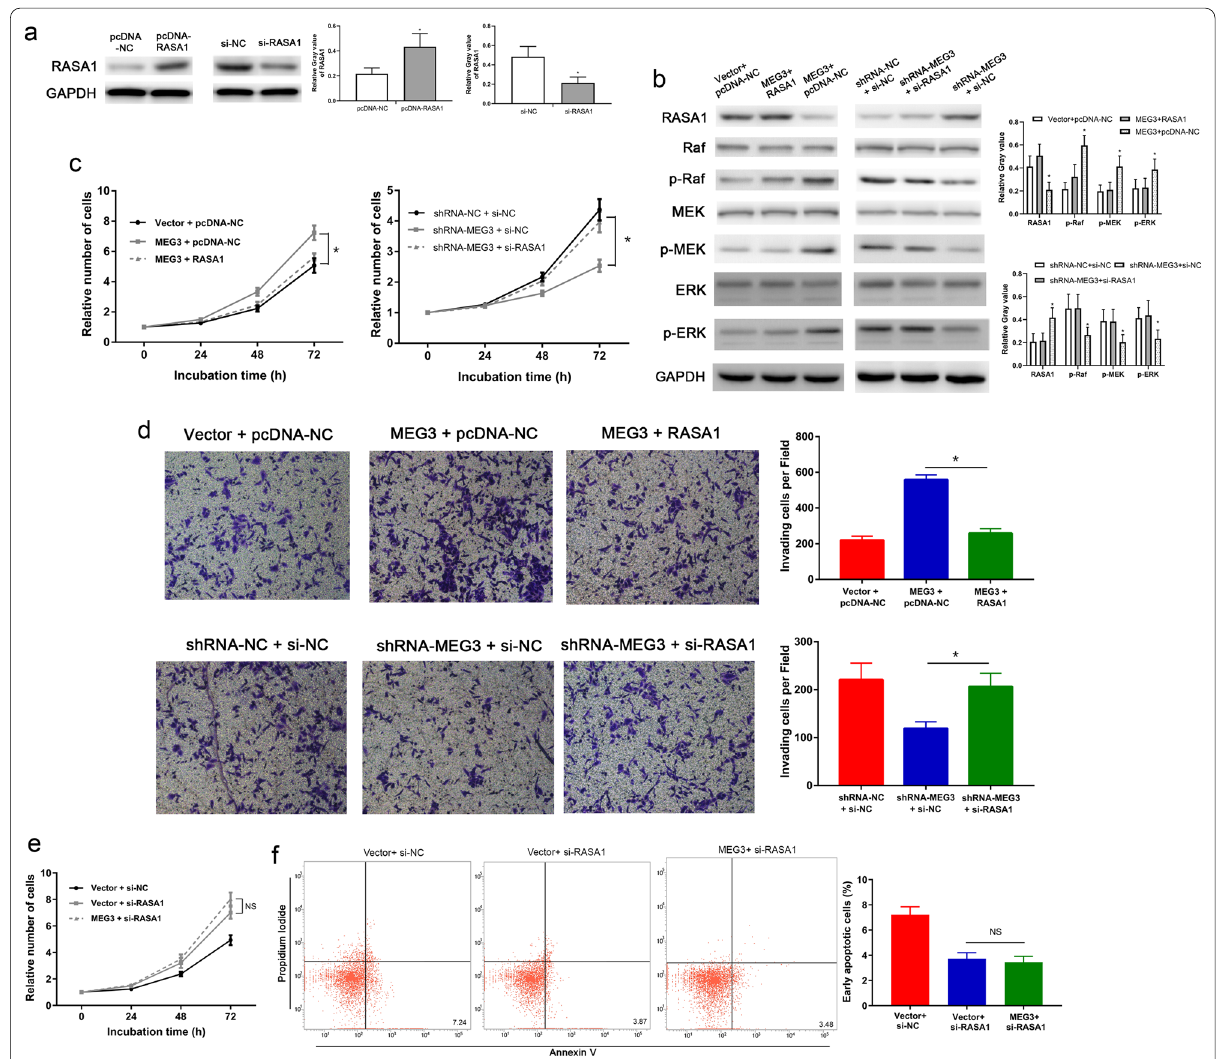
Fig. 7 MEG3 modulated the RAS-MAPK pathway by regulating the expression of the RASA1 gene. Western blot assay: a Effects of pcDNA-RASA1 and si-RASA1 on the RASA1 protein level in PT-U cells. b RASA1-mediated regulation in the activities of Raf, MEK, and ERK proteins in the RAS-MAPK pathway by MEG3. c The CCK-8 assay confirmed that RASA1 mediates the regulation of the proliferative capacity of PT-U cells by MEG3. d Transwell assay confirmed that RASA1 mediates the regulation of the invasive capacity of PT-U cells by MEG3. e and f CCK-8 and flow cytometry assay show that MEG3 has no effect when there is low RASA1 in PT-U cells (Vector si-RASA1 V.S. MEG3 si-RASA1). *P < + +